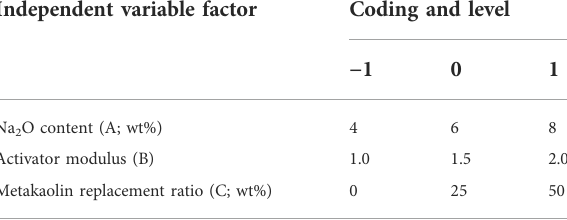
TABLE 2 Response surface factor design and horizontal coding. Independent variable